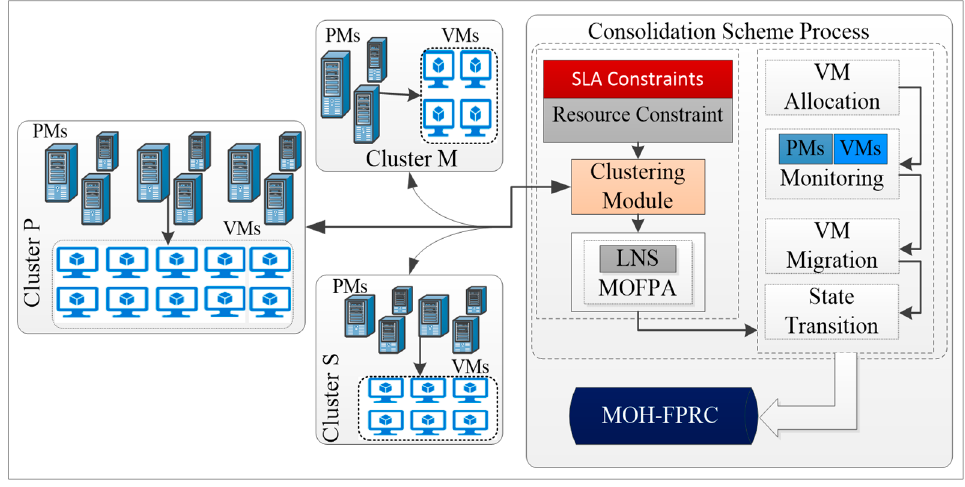
Figure 1. Scheme 1 Schematic Diagram of MOH-FPRC. Figure 1. Schematic Diagram of